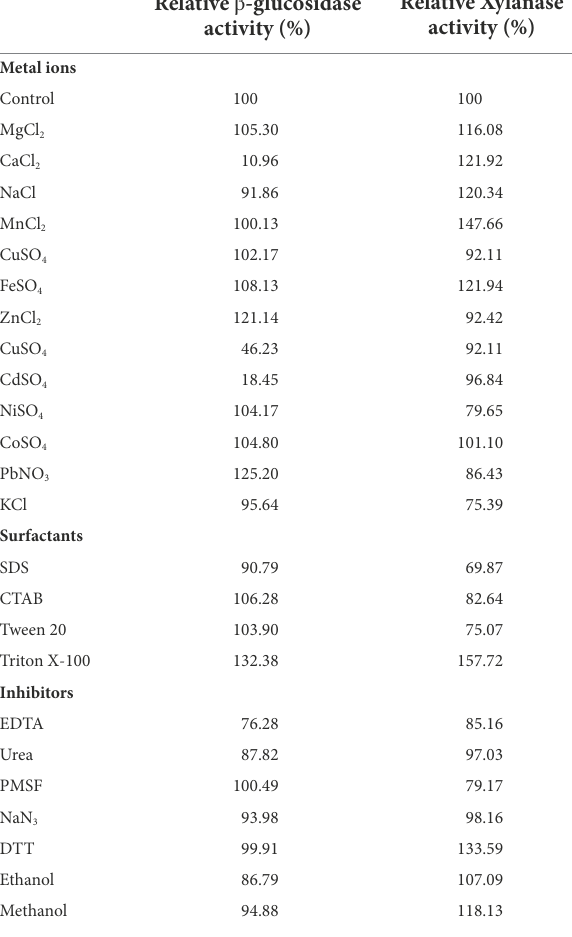
TABLE 1 Effect of metal ions, chemical agents and detergents on β -glucosidase and xylanase activities of the PersiXynBGL1. Relative β -glucosidase activity